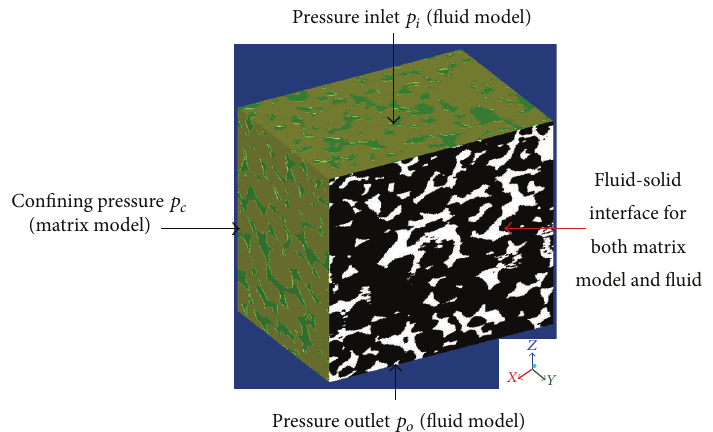
Figure 5: Boundary conditions in the simulation.